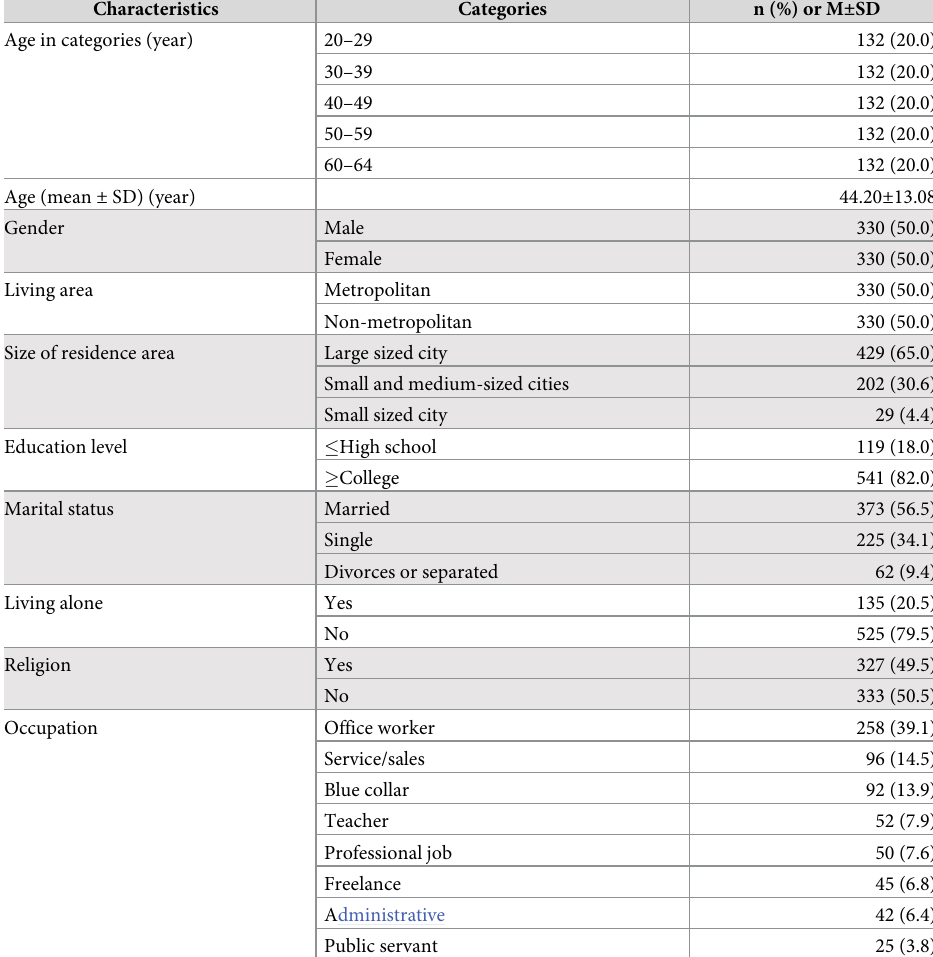
Table 1. General characteristics of the participants (n =